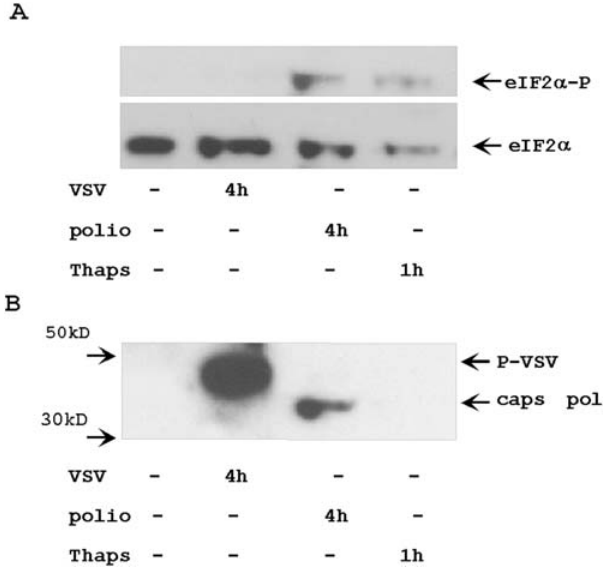
Figure 11. Different activation of eIF2 a phosphorylation by VSV and poliovirus infections. HeLa cells were infected with VSV for 4 h, infected with poliovirus for 4 h, or treated with 1 m M of thapsigargin for 1 hour. Cytoplasmic protein extracts from these and control cells were analyzed with Abs against eIF2 a and phosphorylated form of eIF2 a (panel A). Same membrane was analyzed with Abs against VSV P- protein and poliovirus capsid proteins (panel B).